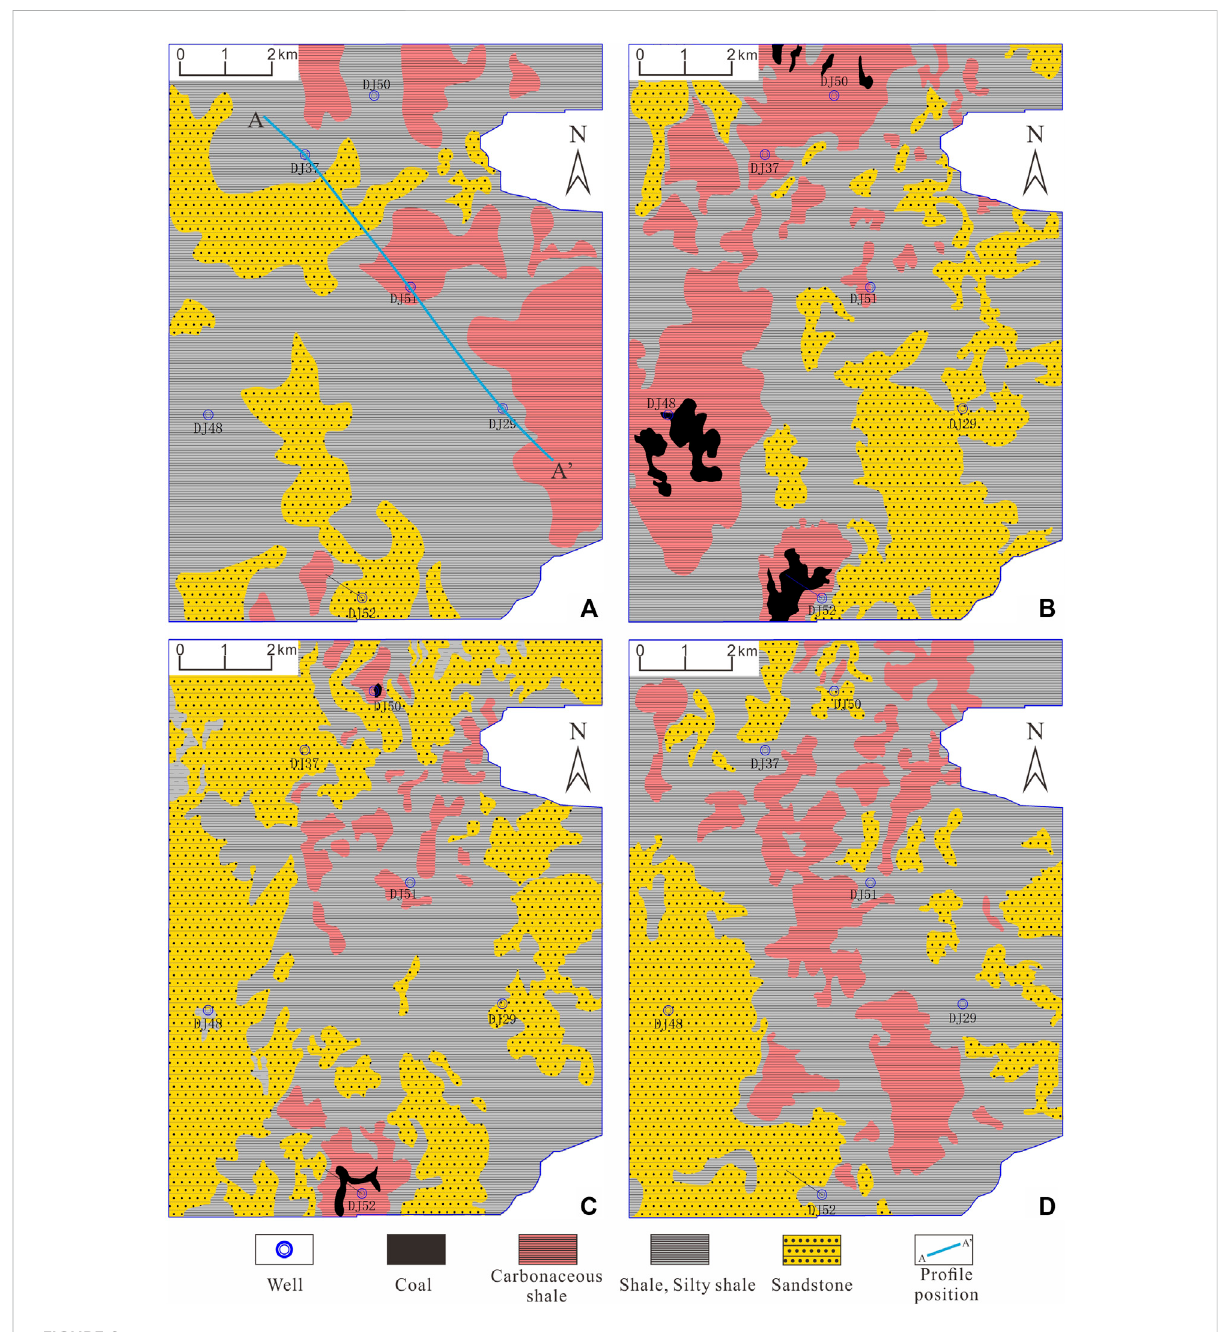
FIGURE 9 Lithologic plane distribution of each section in the Shan-2 Lower Sub-member in the eastern Ordos Basin. (A) Section 4; (B) Section 3; (C) Section 2; (D) Section 1.